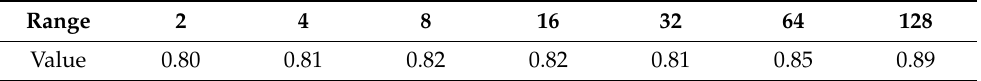
Table 3. Hurst coefficient values calculated by the RoverS method for a specific range. Range